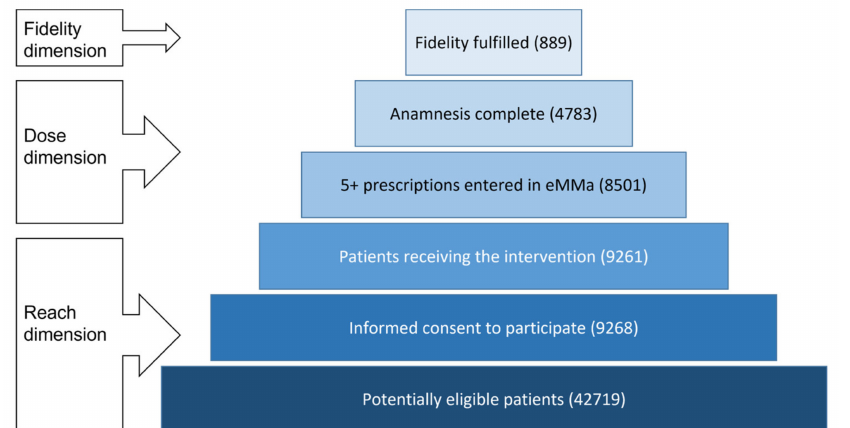
Figure 5. Steps to be climbed in order to achieve Intervention Fidelity. The left-hand legend shows the dimensions impacted by the